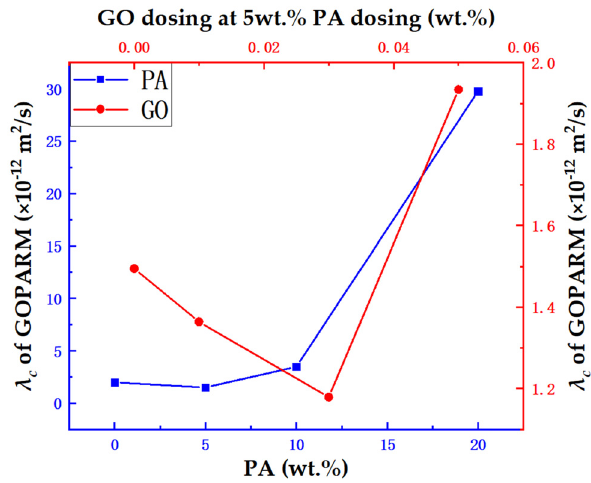
Figure 8: E ff ect of PA and GO dosage on the λ c of